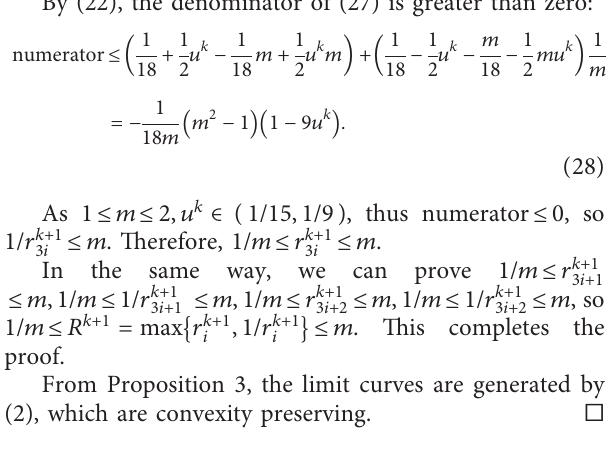
Figure 5: Limit curve by our scheme when lim